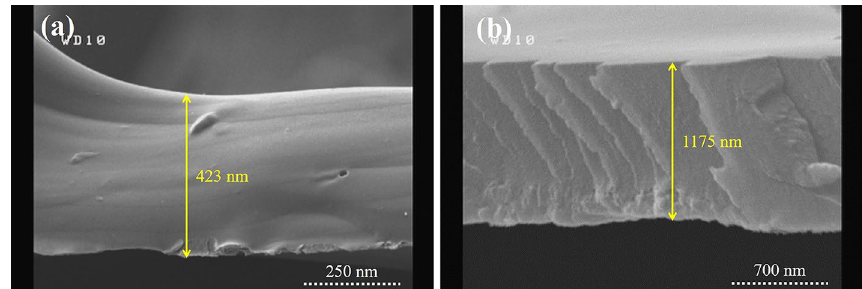
Figure 6. Cross sectional SEM images of Gelatin-coating (a) 3 layers and (b) 7 layers.